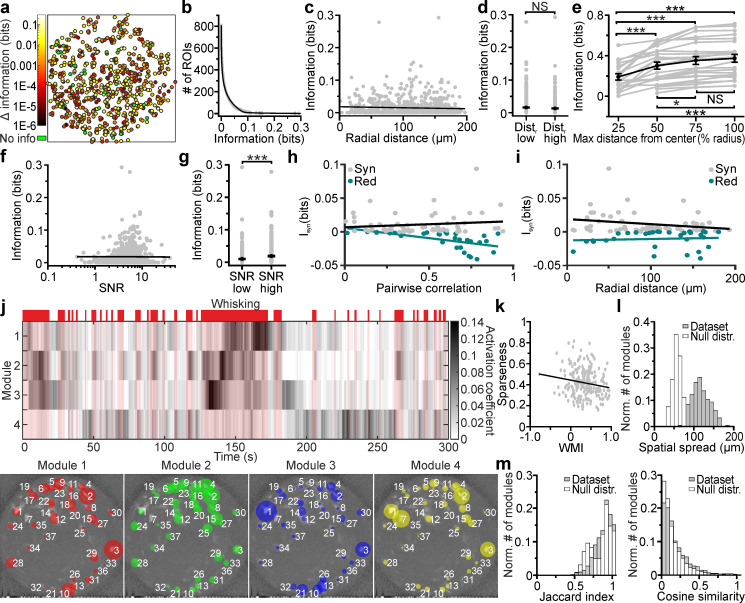
Cell-specific encoding of behaviorally-dependent information in distributed VPM subnetworks.(a) Spatial map of neurons encoding whisking information. The pseudocolor scale shows significantly informative neurons (see Materials and methods). Data are pooled from 24 t-series from four animals. See also Figure 7—figure supplement 1. (b) Distribution of information content in individual ROIs. The individual ROIs information content distribution was fitted using a double exponential function (R2 = 0.99). n = 808 ROIs from 24 time series. (c) Information content of individual neurons vs. their radial distance from the center of the FOV. n = 842 neurons from 24 time series. Linear regression fit: slope = −3E-5, Student’s t-test p=0.13. Pearson correlation coefficient: −0.053, Student’s t-test p=0.13. (d) Information content for ROIs located at low radial distance (distr low) and in lateral portions of the FOV (distr high). n = 425 and 417 ROIs from 24 t-series for distr low and distr high, respectively. Mann-Whitney test, p=0.42. (e) Information content of neural populations as a function of the distance from the FOV center (% radius) used to include ROIs in the population. One-way ANOVA repeated measurements with Bonferroni post hoc, p=1E-18. Data pooled from 24 time series. (f) Information content of individual neurons vs. SNR. n = 842 neurons from 24 time series. Linear regression fit: slope = 9E-4, Student’s t-test p=2.7E-4. Pearson correlation coefficient: 0.125, p=2.7E-4. (g) Information content for ROIs with low SNR (SNR low) and high SNR (SNR high). n = 421 and 421 ROIs from 24 t-series for distr low and distr high, respectively. Mann-Whitney test, p=5E-5. (h,i) Synergistic (gray) or redundant (dark green) information within pairs of neurons is shown as a function of pairwise correlation (h) and as a function of radial distance (i). n = 61 and 31 pairs of neurons for synergistic and redundant information content, respectively. Data from 24 time series. Linear regression fit in (h): slope = 0.008, permutation test p=0.45 and slope = −0.02, permutation test p=0 for synergistic and redundant information, respectively. Linear regression fit in (i): slope = −0.0001, permutation test p=0.007 and slope = 2E-5, permutation test p=0.38 for synergistic and redundant information, respectively. (j) Top: representative grayscale matrix showing the activation coefficient across time for 4 NMF modules emerging in a FOV containing 37 neurons. Periods of whisking are shown in red bars and shades. Bottom: ROIs belonging to the four different modules shown in the top panel. Each colored circle represents a ROI belonging to the specified module and its radius is proportional to the ROI weight within that module. The corresponding activation coefficients are presented in the upper panel. (k) Module sparseness as a function of the whisking modulation index (WMI). n = 213 modules from 24 time series. Pearson correlation coefficient: −0.164, p=0.016. (l) Normalized number of modules as a function of their spatial spread for the experimental data (gray) and for a null distribution obtained by randomly shuffling the spatial position of ROIs in the FOV (white). Number of modules: n = 213 and n = 2400 for the 24 t-series of the in vivo dataset and for the null distribution, respectively. (m) Left: Normalized number of modules as a function of their Jaccard index for pairs of modules identified within the same FOV for experimental data (gray) and for a null distribution (white) obtained by randomly shuffling the spatial position of ROIs within the FOV. Number of modules: n = 1704 and n = 34080 for the 24 t-series of the experimental data and for the null distribution, respectively. Right: same as in the left panel for Cosine similarity coefficients.Figure 7—source data 1.Information theoretical analysis and non-negative matrix factorization results.Values of cell-specific and population information analysis.